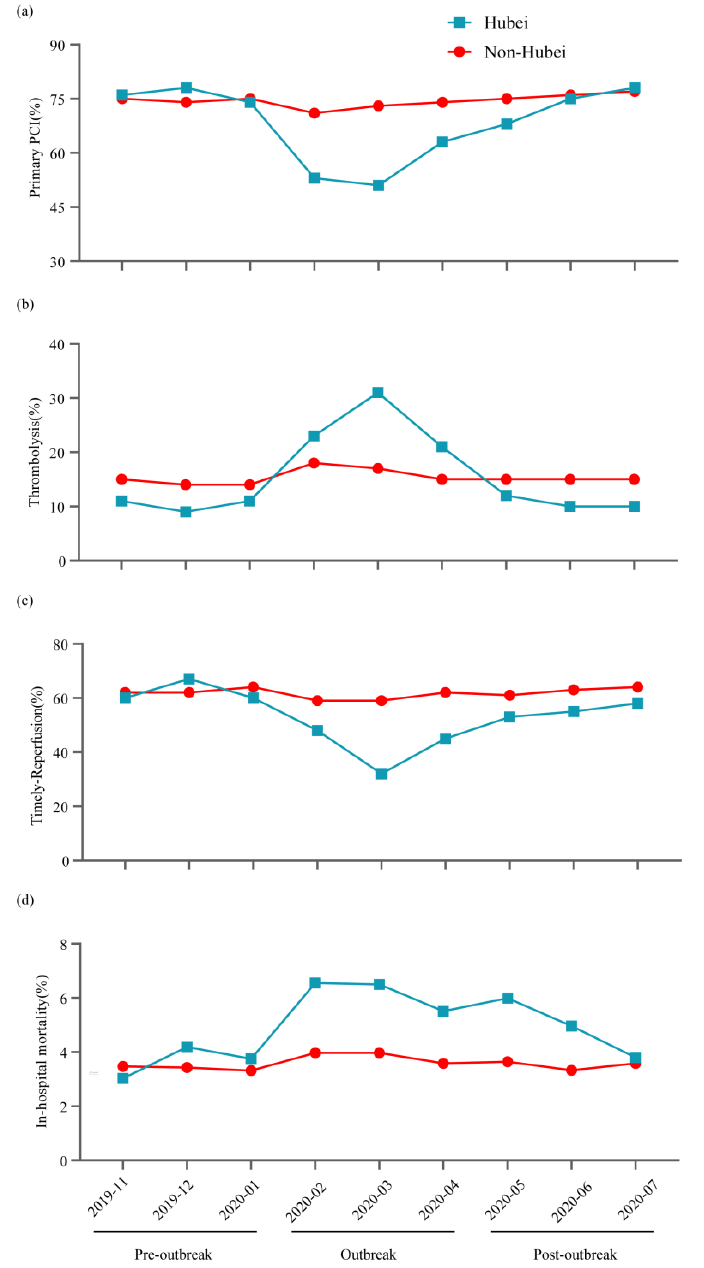
Figure 1. Changes of reperfusion and mortality. Percentages of STEMI patients receiving primary percutaneous coronary intervention (PCI) ( a ), thrombolysis ( b ), timely reperfusion (system delay (primary PCI) ≤ 120 min or system delay (fibrinolysis) ≤30 min) ( c ), and patterns of in-hospital mortality ( d ).